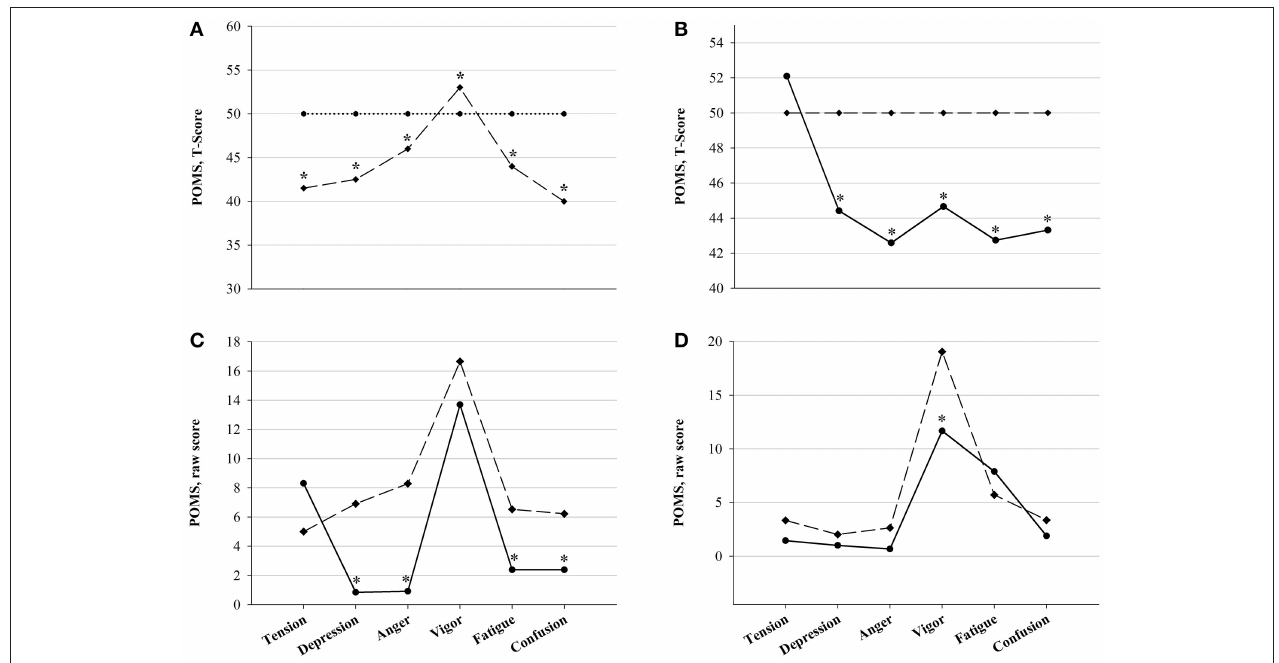
FIGURE 9 | Comparison of POMS results with normative data (Unpaired Student’s t -Test). (A) Iceberg profile of mood states in an athletic sample (dashed line) plotted against sedentary subject norms (dotted line), (B) Mood states in all YAU subjects (ALL, solid line) plotted against normative data for mixed athletic samples (dashed line), (C) Mood states in ALL at PRE (solid line) plotted against normative data for pre-competition assessment (dashed line), (D) Mood states in ALL at POST (solid line) plotted against normative data for post-competition assessment (dashed line): * p < 0.05 between